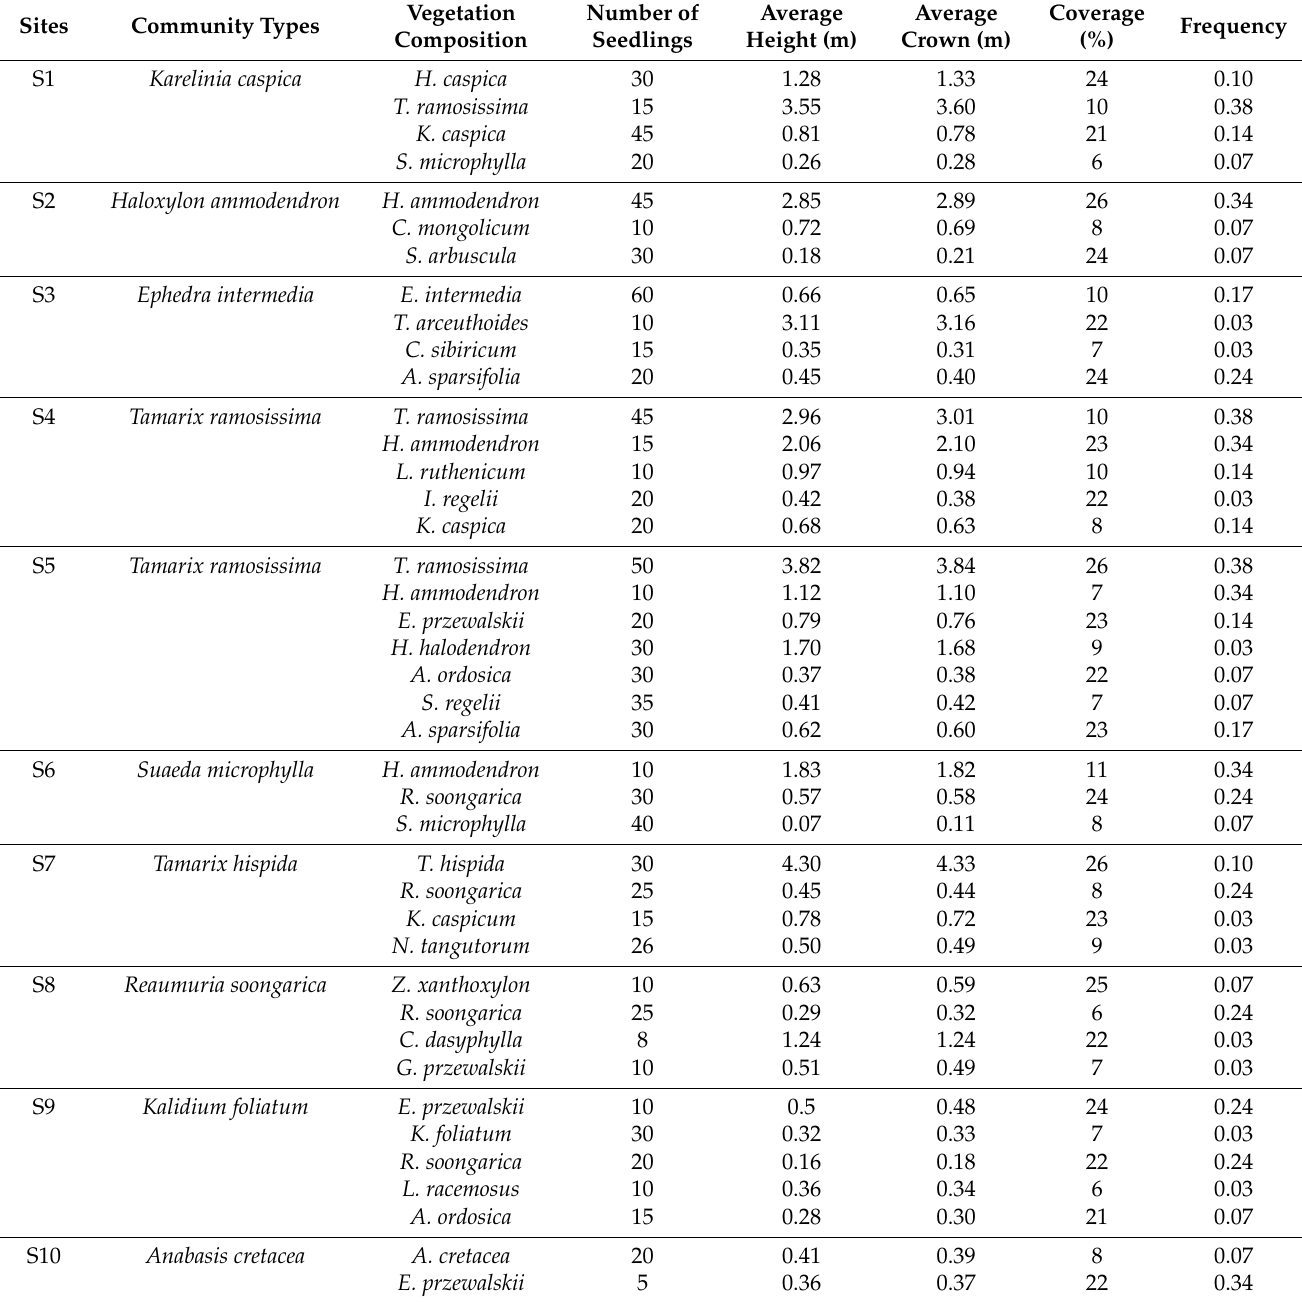
Table 3. Plant composition and structural characteristics of different community